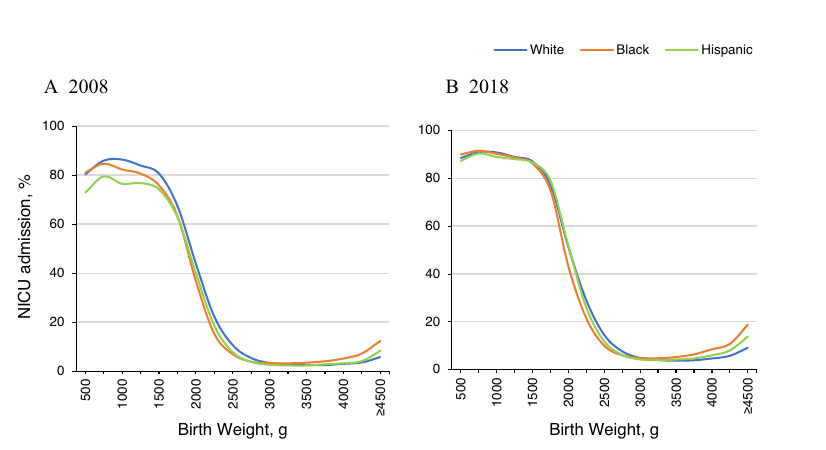
Figure 3. NICU admission across birth weight by race/ethnicity, 2008 vs